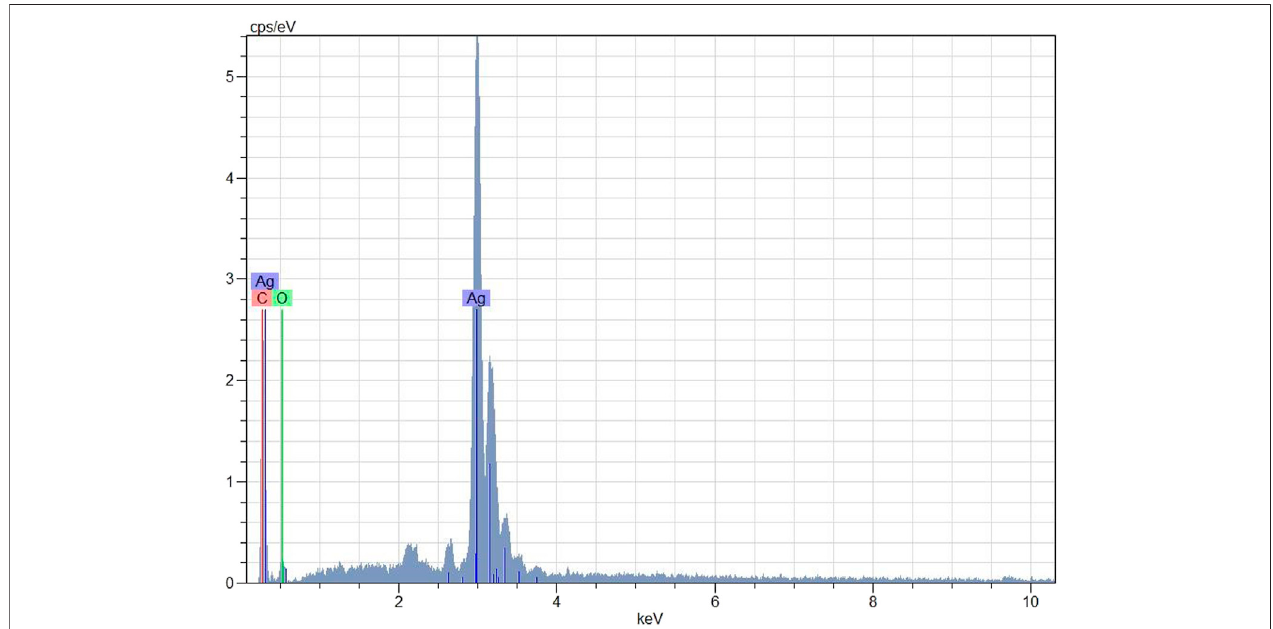
FIGURE 6 | Elemental composition of AgNPs with EDX analysis.